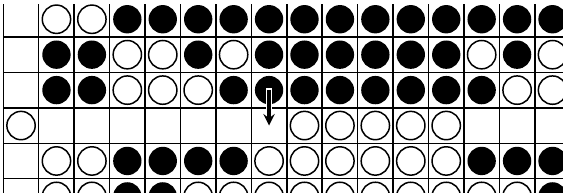
Figure 84. The center WHITE leaves.